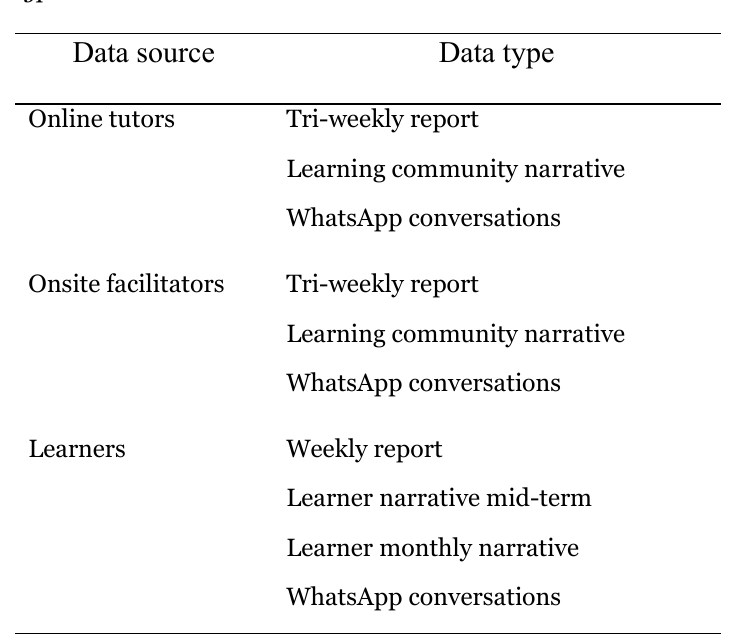
Data Sources and